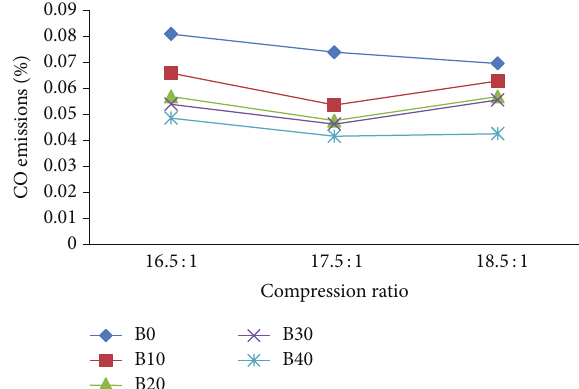
Figure 12: Variation of CO emission with compression ratio for all blends at 75% of rated load